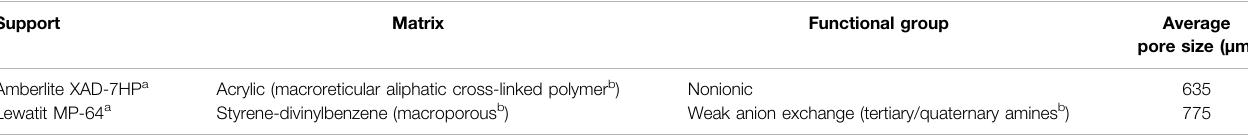
TABLE 1 | Characteristics of support resin for the immobilization of Aspergillus niger